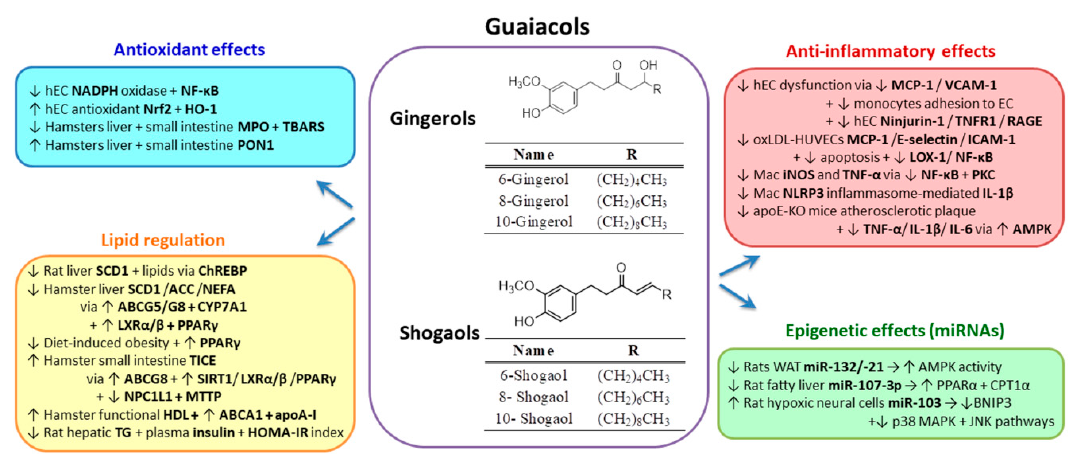
Figure 9. Guaiacols’ classifications, chemical structures and molecular mechanisms of action to reduce cardiovascular diseases.